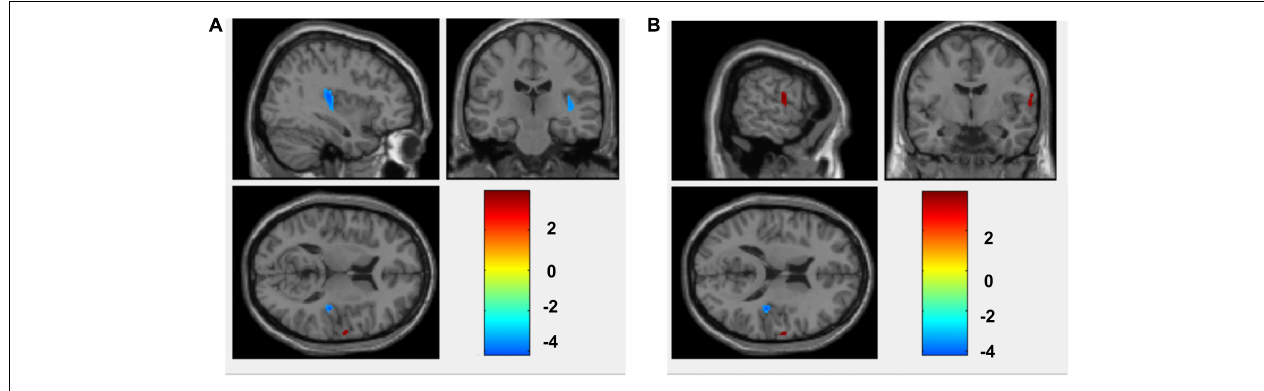
FIGURE 1 | CBF differences between anxiety and non-anxiety group patients with pulmonary nodules. (A) The blue area represents CBF decrease (Insula_R/Heschl_R). (B) The red area represents CBF increase (Postcentral_R).